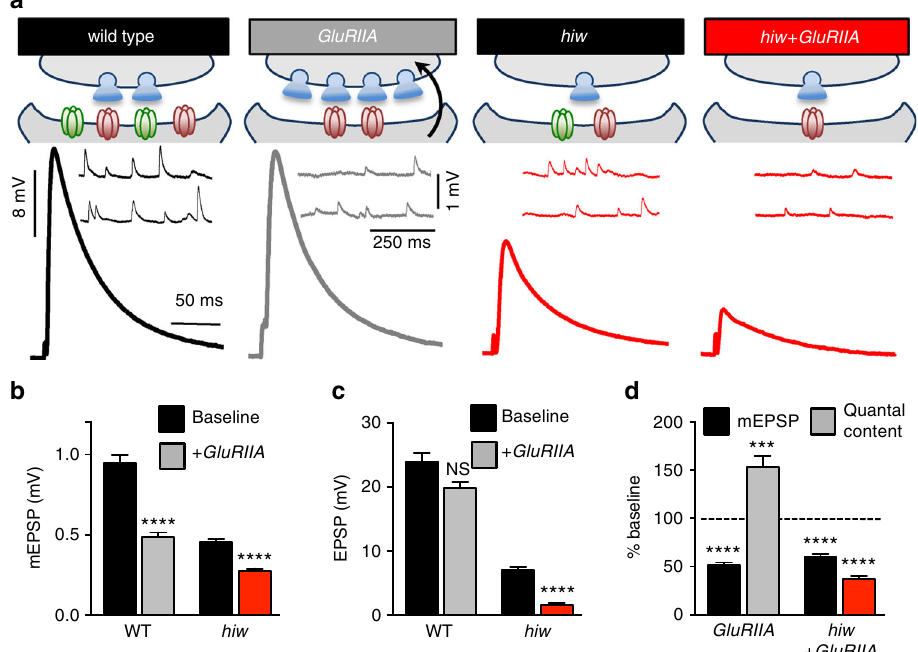
Fig. 5 hiw mutants fail to express PHP following chronic loss-of -GluRIIA receptors. a Schematic and representative EPSP and mEPSP traces of recordings in wild type, GluRIIA mutants ( GluRIIA : w;GluRIIA SP16 ), hiw mutants, and hiw;GluRIIA double mutants ( hiw Δ N ;GluRIIA SP16 ). Quanti fi cation of mEPSP ( b ) and EPSP ( c ) amplitude in the indicated genotypes shows a reduction in mEPSP amplitude but failure to maintain baseline EPSP levels in hiw;GluRIIA . d Quanti fi cation of mEPSP and quantal content values normalized to baseline (without loss-of- GluRIIA ) of the same genotype. No homeostatic increase in quantal content is observed in hiw;GluRIIA mutants. Error bars indicate ± SEM. For statistical signi fi cance, an unpaired t -test was performed. *** p 0.001; **** p 0.0001; NS not signi fi cant, p > 0.05